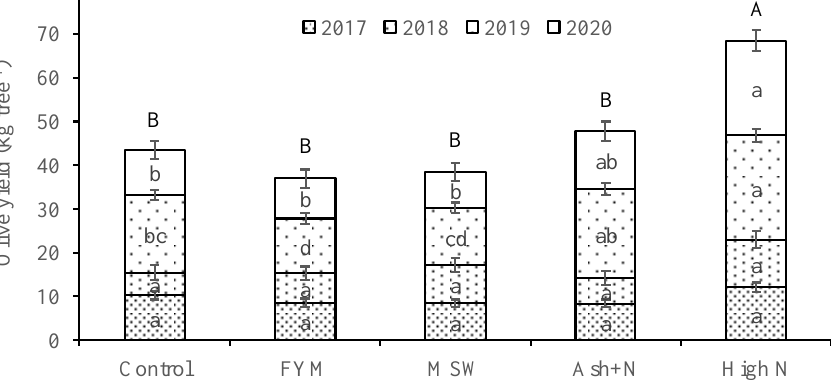
Figure 2. Olive yield in four consecutive harvests as a function of fertilizer treatments: control, compound NPK (50 kg ha − 1 of N, P 2 O 5 and K 2 O); FYM, farmyard manure (rate equivalent of 50 kg N ha − 1 ); MSW, municipal solid waste (rate equivalent of 50 kg N ha − 1 ); Ash + N, bottom ash (4 t dw ha − 1 ) plus 50 kg N ha − 1 ; and High N, high N rate (120 kg N ha − 1 and 50 kg ha − 1 P 2 O 5 and K 2 O). Within each year (lowercase) and total (uppercase), means followed by the same letter are not significantly different by Tukey HSD test ( α = 0.005). Vertical bars are standard errors.